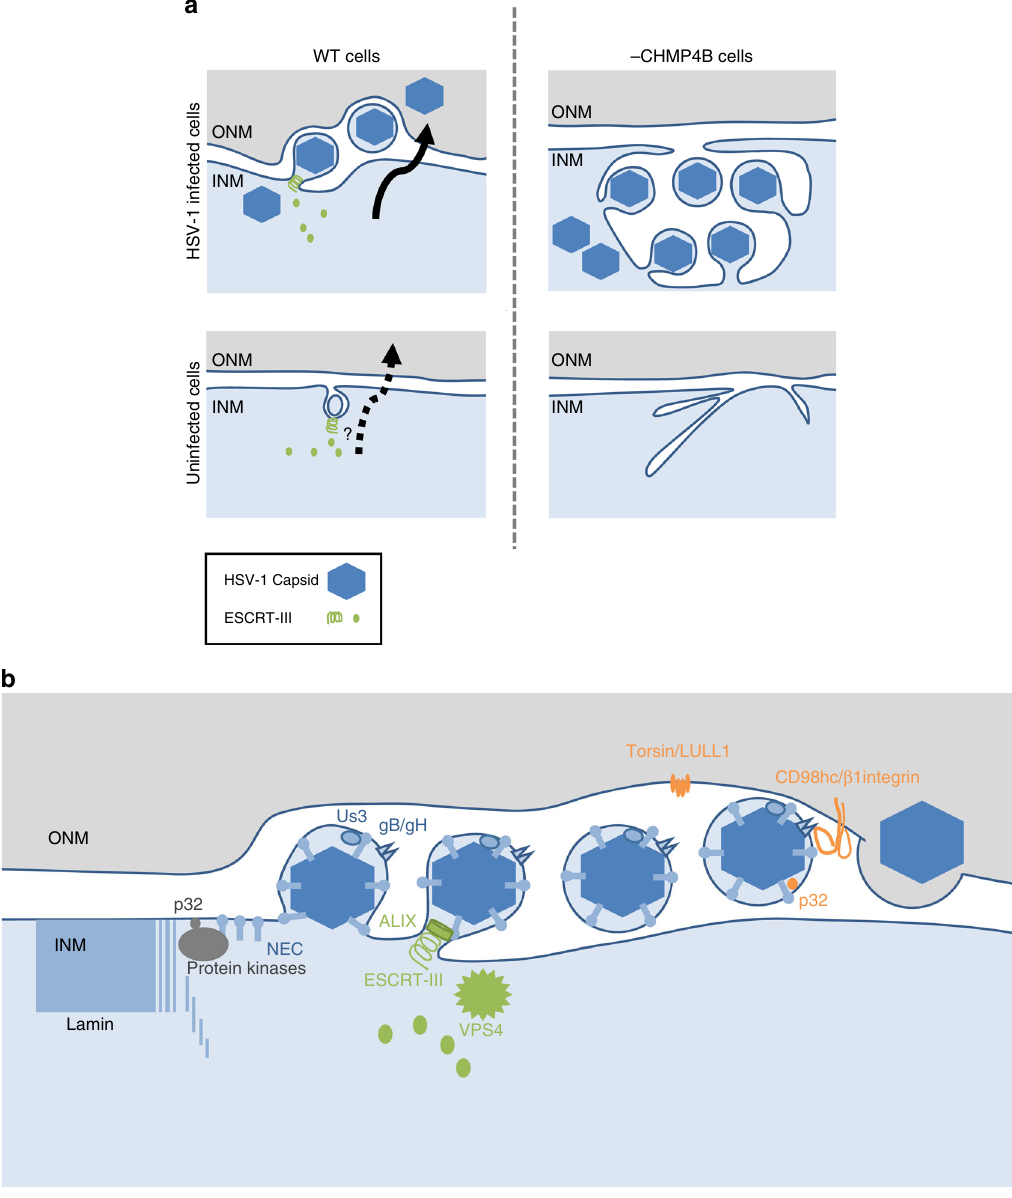
Fig. 10 Model for INM scission by ESCRT-III. a In HSV-1-infected cells, ESCRT-III is recruited to INM sites, where HSV-1 capsids acquire a primary envelope that functions in INM scission to produce primary enveloped virions in the perinuclear space. Depletion of CHMP4 proteins impairs primary envelopment and produces an accumulation of primary enveloped virions in the invagination structures in the nucleus. Nuclear morphology is maintained by the lamina meshwork but HSV-1 infection dissociates nuclear lamina 6 . Thus, arrested virions might be mainly accumulated in the invagination structures derived from the INM. In normal (uninfected) human cells, ESCRT-III contributes to downregulate excess INM. This process might be similar to the vesicle-mediated nucleocytoplasmic transport of HSV-1 nucleocapsids. CHMP4 KO increases the INM proliferation in a manner independent of cell cycle. b Proposed model of vesicle-mediated nucleocytoplasmic transport of HSV-1 nucleocapsids. (i) Protein kinases recruited by the NEC induce local dissolution of the nuclear lamina to allow nucleocapsids access to the INM 6 . Host protein p32 contributes to the recruitment of protein kinase C 65 . (ii) The NEC deforms the INM to wrap around the nucleocapsid. (iii) The NEC recruits ESCRT-III machinery via ALIX and mediates INM scission to complete primary envelopment. (iv) The de-envelopment process is still unclear, but a possible role of viral gB and gH together with host protein CD98hc, β 1 integrin, and p32 has been reported 4,5,66 . Phosphorylation of the NEC by the viral Us3 protein kinase promotes de-envelopment 67 . The torsin/LULL1 complex may indirectly contribute to this step